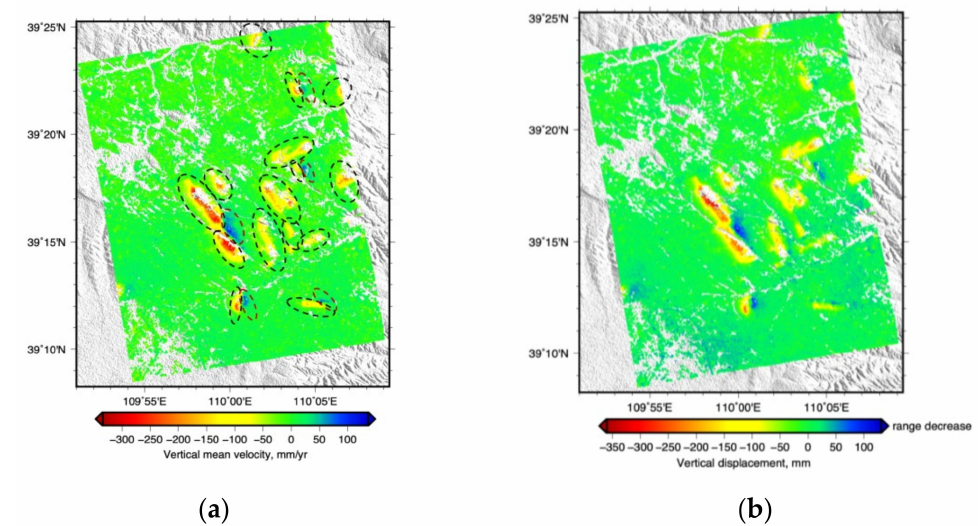
Figure 11. InSAR monitoring results in Shendong Mining Area: ( a ) Rate of vertical surface deforma- tion; ( b ) Accumulated surface